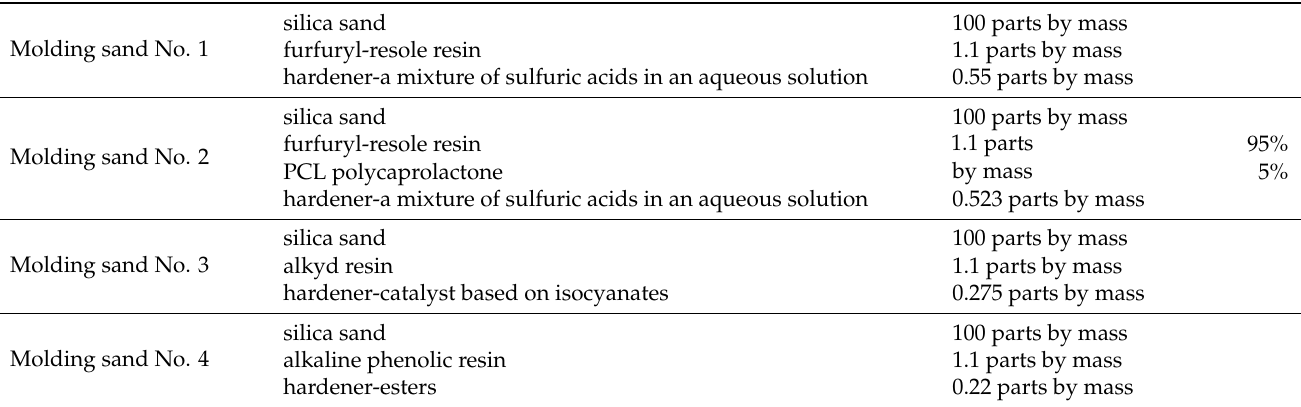
Table 1. The composition of molding sands used in the